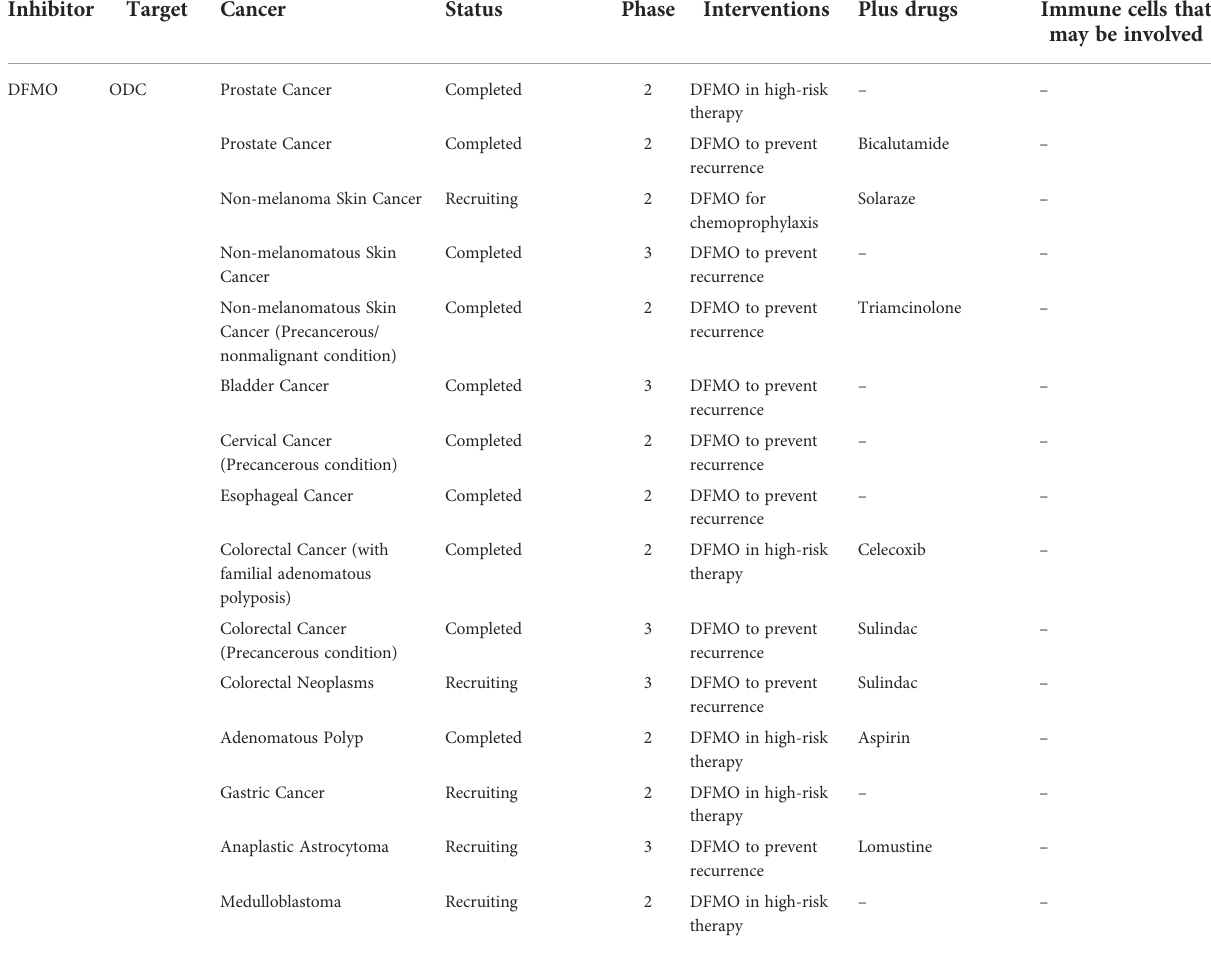
TABLE 1 Polyamine metabolism interventions in cancers: Clinical